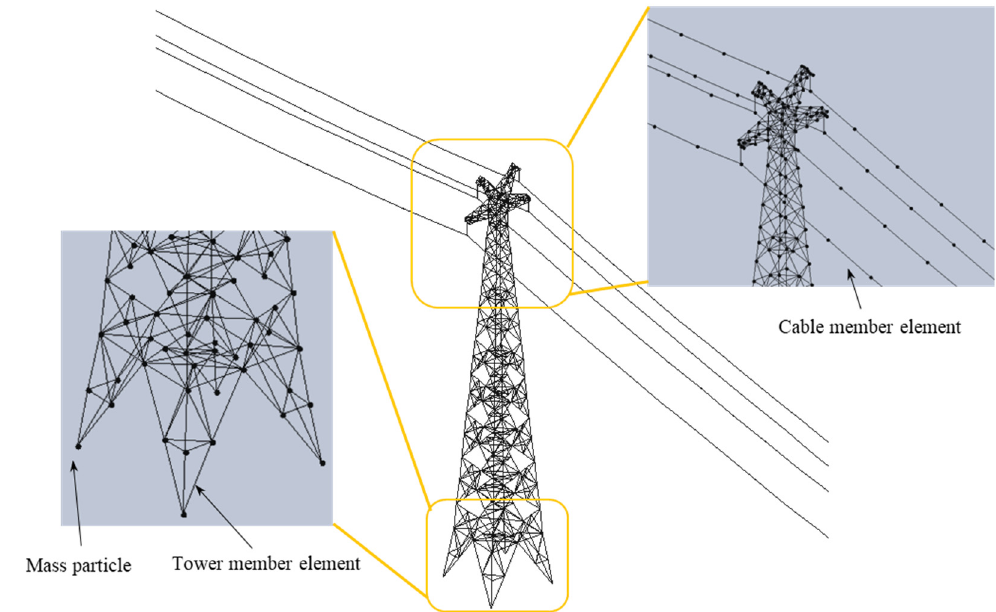
Figure 6. The discretization model of the tower-line system.